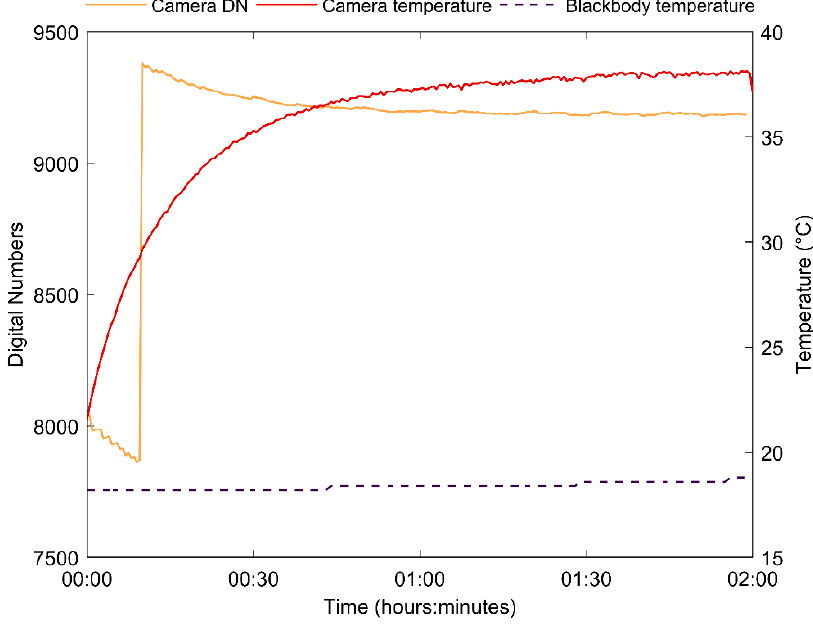
Figure 2. Time series of camera digital numbers (DN), temperature of the camera and blackbody temperature for the first two hours after camera activation.